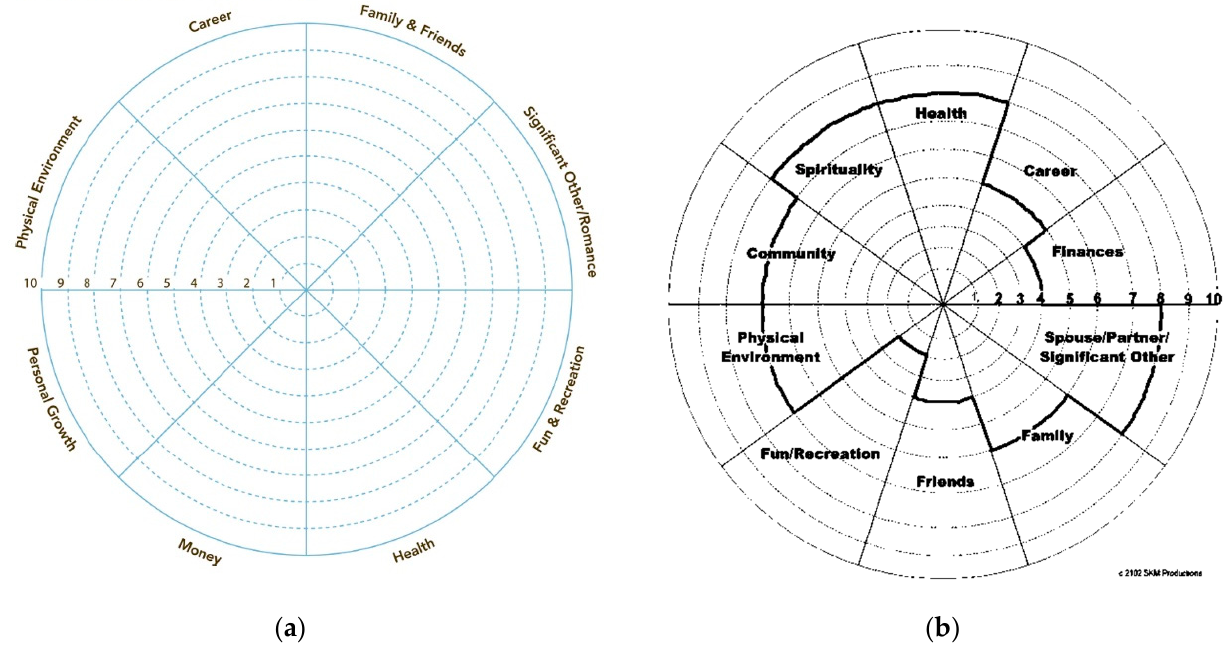
Figure 1. ( a )Wheel of life by Paul J. Meyer; ( b )Wheel of life by Paul J. Meyer (example completed). Figure 1. ( a ) Wheel of life by Paul J. Meyer; ( b ) Wheel of life by Paul J. Meyer (example